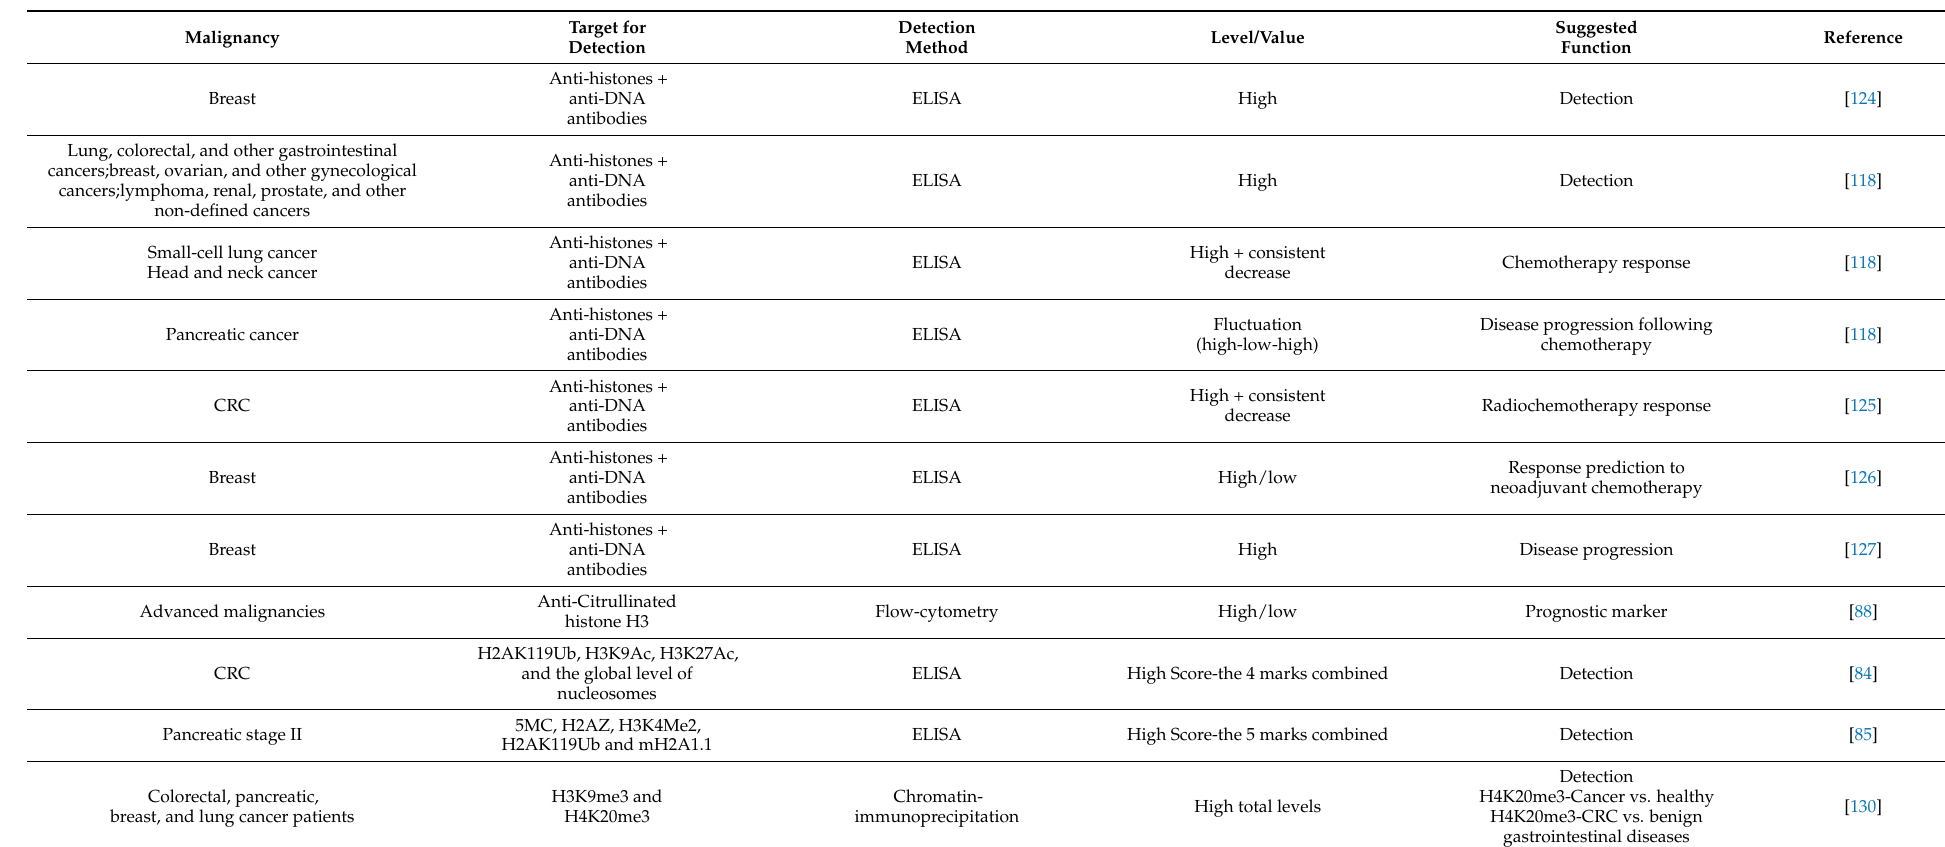
Table 4. Circulating histones and histones complexes in solid